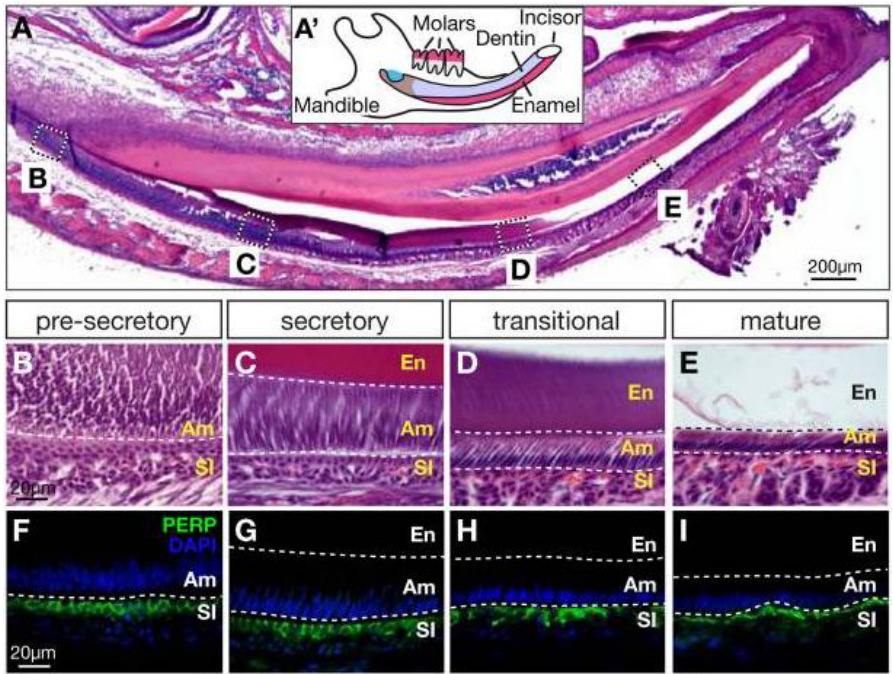
Figure 1. PERP localization in developing incisors at postnatal day 7. (A) H&E staining of the lower incisor and mandible in sagittal section. (A’) Cartoon of the mandible. (B-E) H&E staining of the lower incisor. (F-I) PERP immunofluorescence staining at presecretory, secretory, transitional, and mature stages.